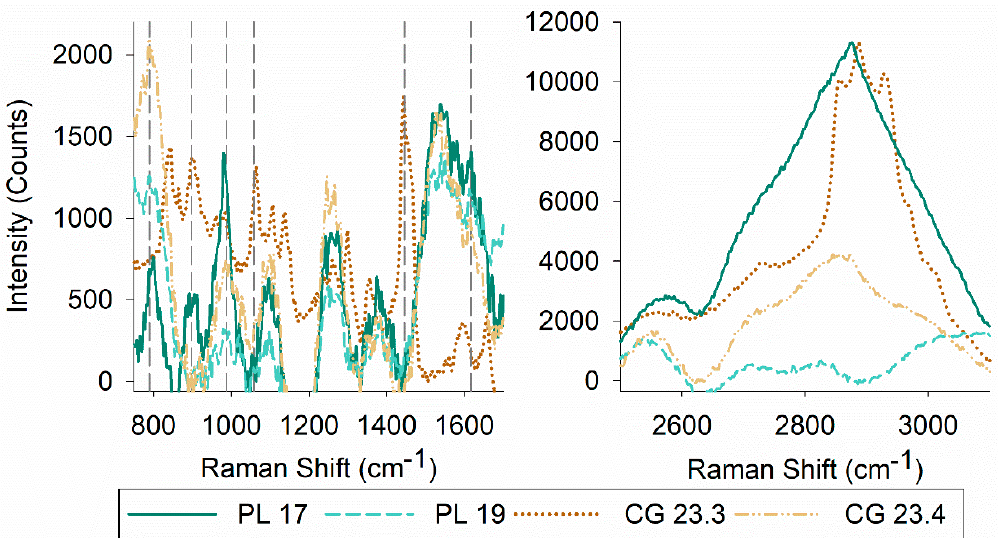
Figure 2. Raman spectra of biosurfactants: ( left panel ) wavenumbers from 750–1700 cm − 1 and ( right panel ) from 2500–3100 cm − 1 . Dashed lines indicate peaks at specific wavenumbers associated with biosurfactants.